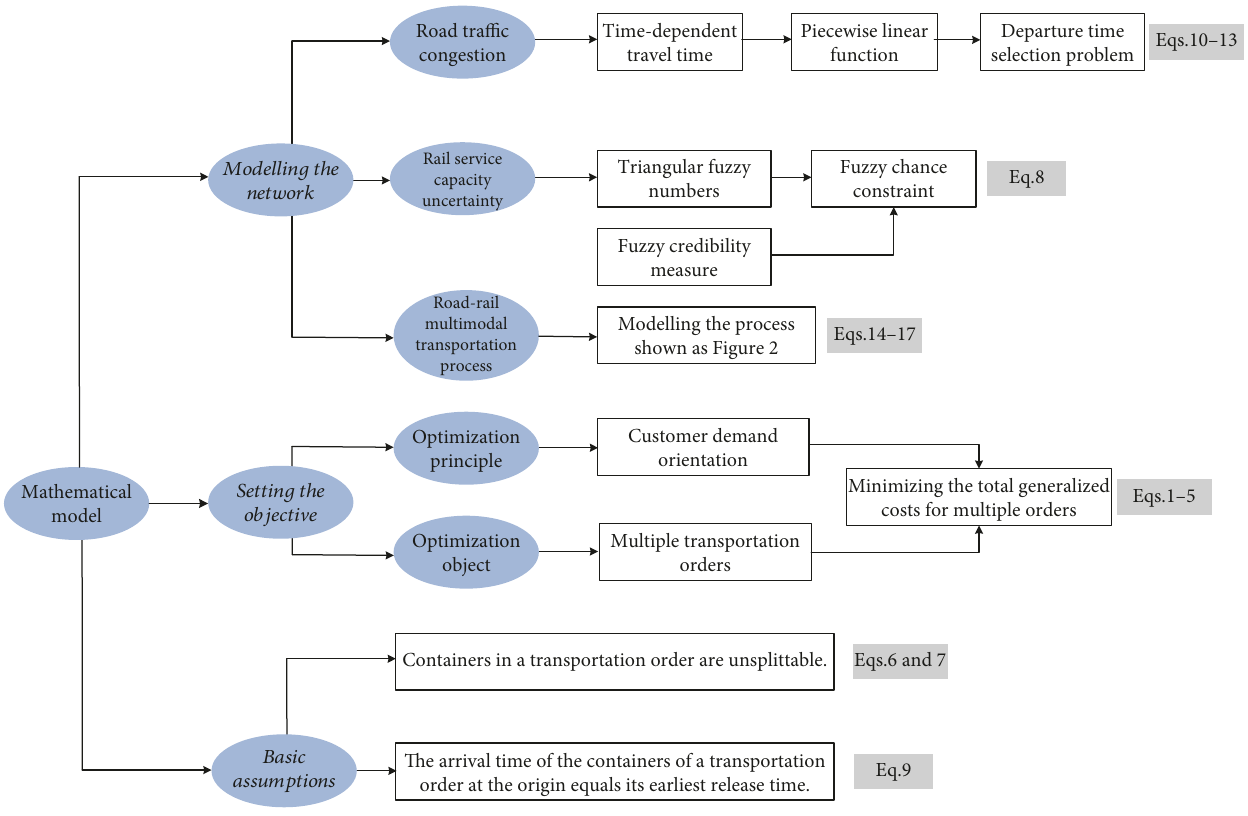
Figure 4: Framework of the mathematical